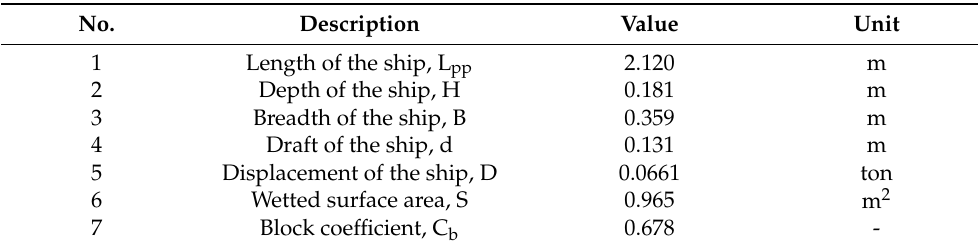
Table 3. Principal dimensions of the bulbous bow